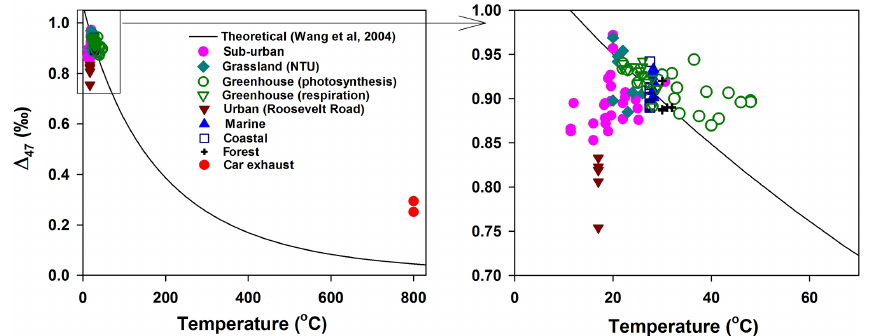
Figure 9. A summary of (cid:49) 47 values in near-surface air CO 2 obtained at different environments and compared with the thermodynamic equilibrium values. Combustion temperature for car exhaust is assumed to be 800 ◦ C (minimum value). Greenhouse CO 2 are divided into two categories: photosynthesis dominated (green open circle) and respiration dominated (green open